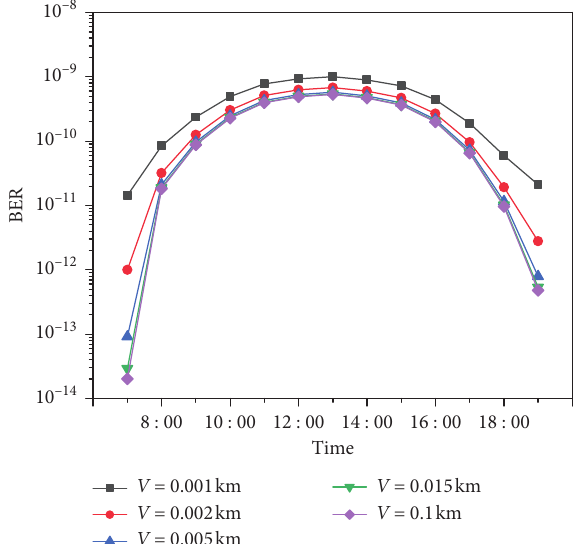
Figure 5: BER for a day in fire smoke environment with different visibility.